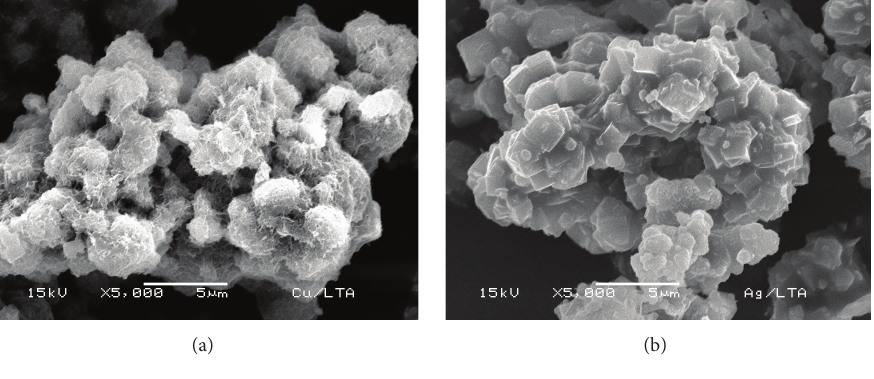
Figure 5: SEM of Cu6%/Z4A (a) and Ag15%/Z4A (b).